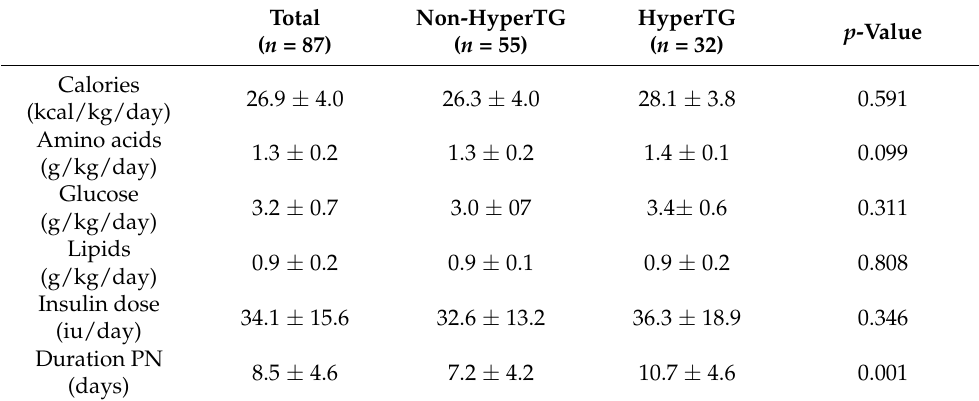
Table 2. Initial composition of macronutrients and parenteral nutrition